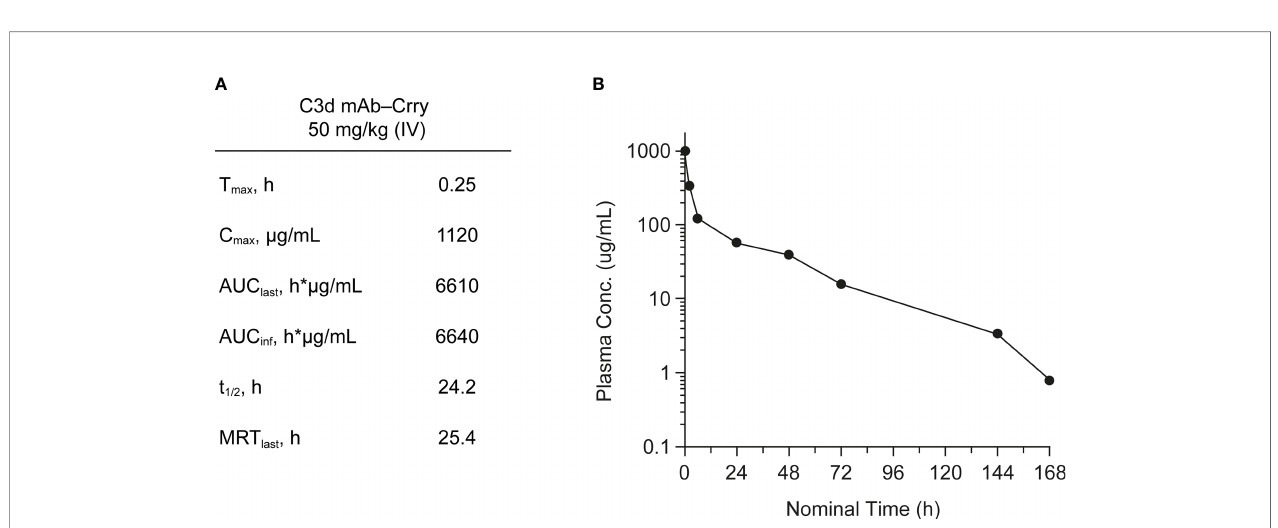
FIGURE 7 | Mean pharmacokinetic parameters (A) and plasma concentrations (B) of C3d mAb − Crry post-dosing by IV administration at 50 mg/kg. AUC last , area under the curve from time zero to the last measurable concentration; AUC inf , AUC from time zero extrapolated to in fi nity; C max , maximum plasma concentration; MRT, mean residence time; t 1/2 , half-life; T max , time to maximum plasma